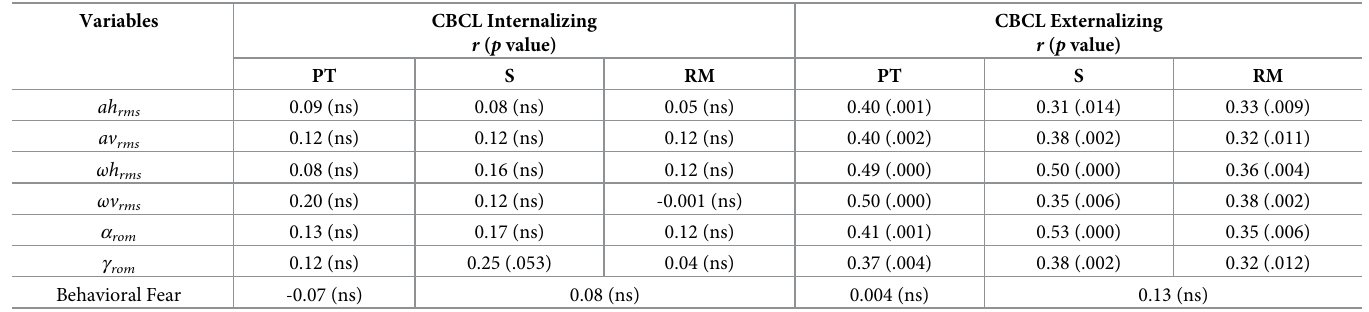
Table 5. Correlations between parent-reported child behavior problems, child movement, and coded behavioral data. Variables